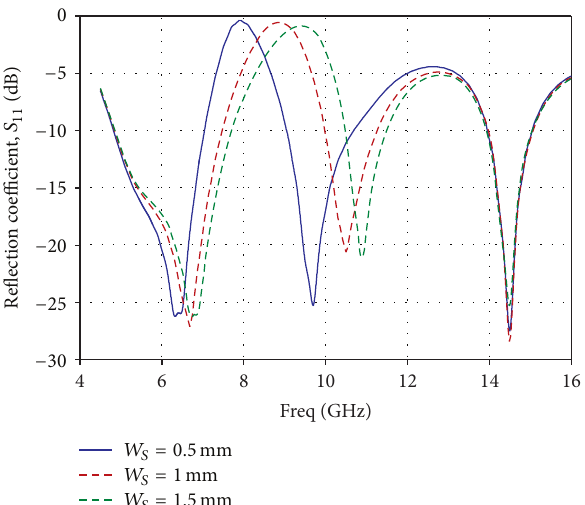
Figure 6: Magnitude of the simulated reflection coefficient of the PIFA versus frequency for different values of the geometrical parameter 𝑊 𝑆 .